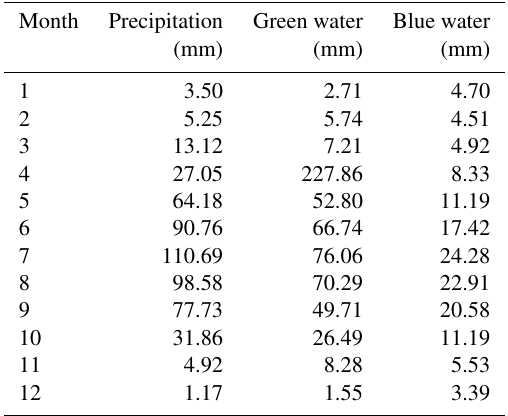
Figure 7. The inter-annual variability of the precipitation and blue